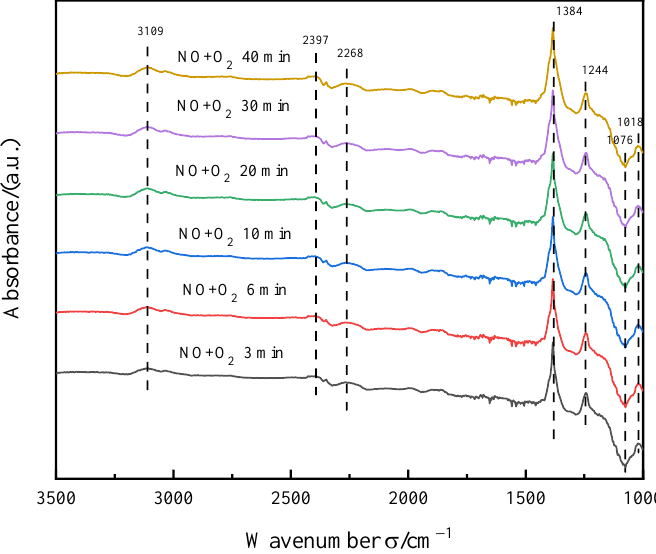
Figure 7. In situ DRIFTS of NO+O 2 adsorbed over the 4Cu-4Ce-4Zr/SAPO-34 catalyst.